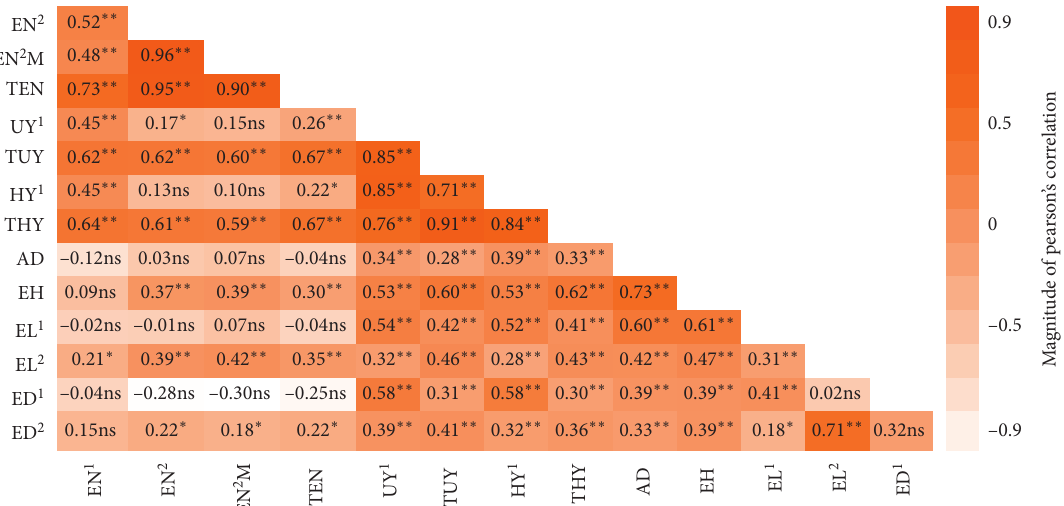
Figure 4: Triangular heat map representing Pearson’s correlation coefficients between yields, yield components, and agronomic characters of small-ear waxy corn genotypes. EN 1 � ear number at the first ear position, EN 2 � ear number at the second ear position, EN 2 M � marketable ear number at the second ear position, TEN � total of ear number, UY 1 � unhusked yield of the first ear position, TUY � total of unhusked yield, HY 1 � husked yield of the first ear position, THY � total of husked yield, AD � anthesis date, EH � ear height, EL 1 � husked ear length of the first ear position, EL 2 � husked ear length of the second ear position, ED 1 � husked ear diameter of the first ear position, ED 2 � husked ear diameter of the second ear position. ns � not significant; ∗ and ∗∗ significant at p � 0 . 05 and p � 0 . 01,